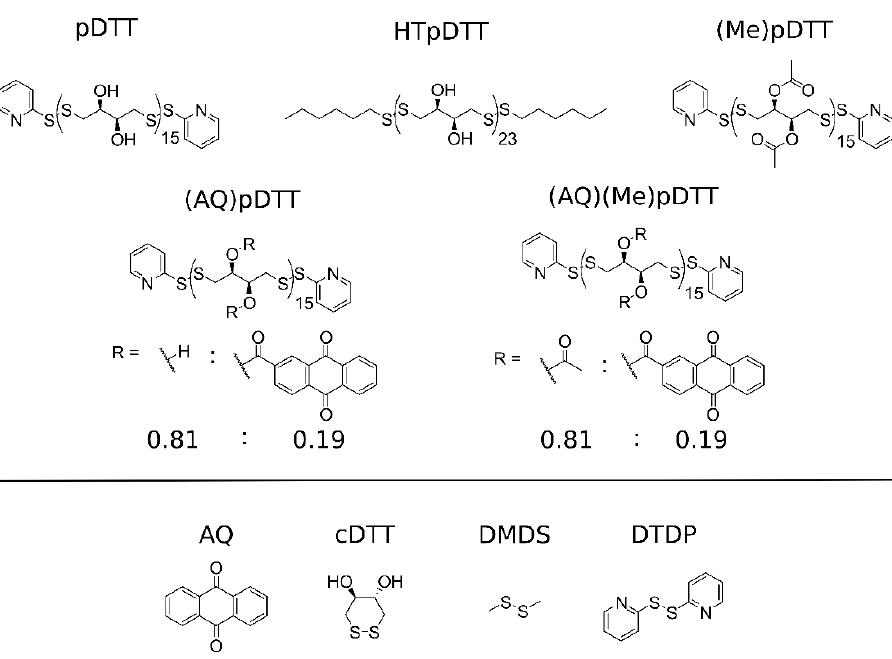
Scheme 1. Chart of poly(dithiothreitol) derivatives ( top ) and model compounds ( bottom